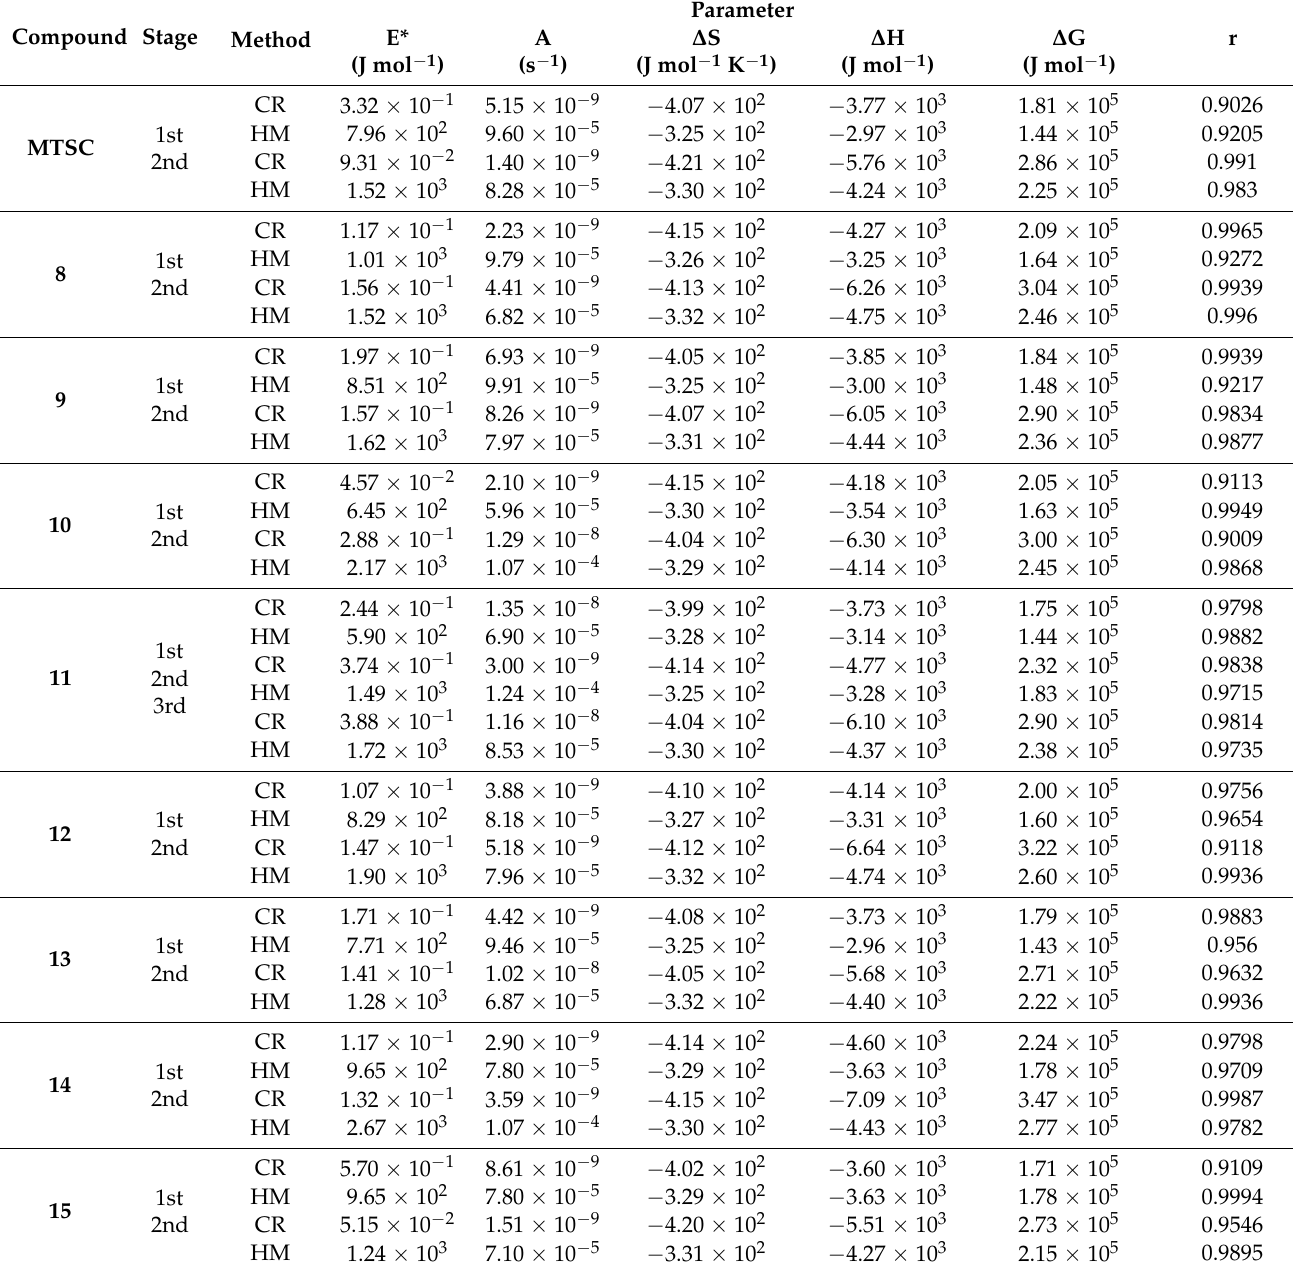
Table 4. The Coats–Redfern (CR) and Horowitz–Metzger (HM) calculations to the MTSC and its metal complexes. Compound Stage